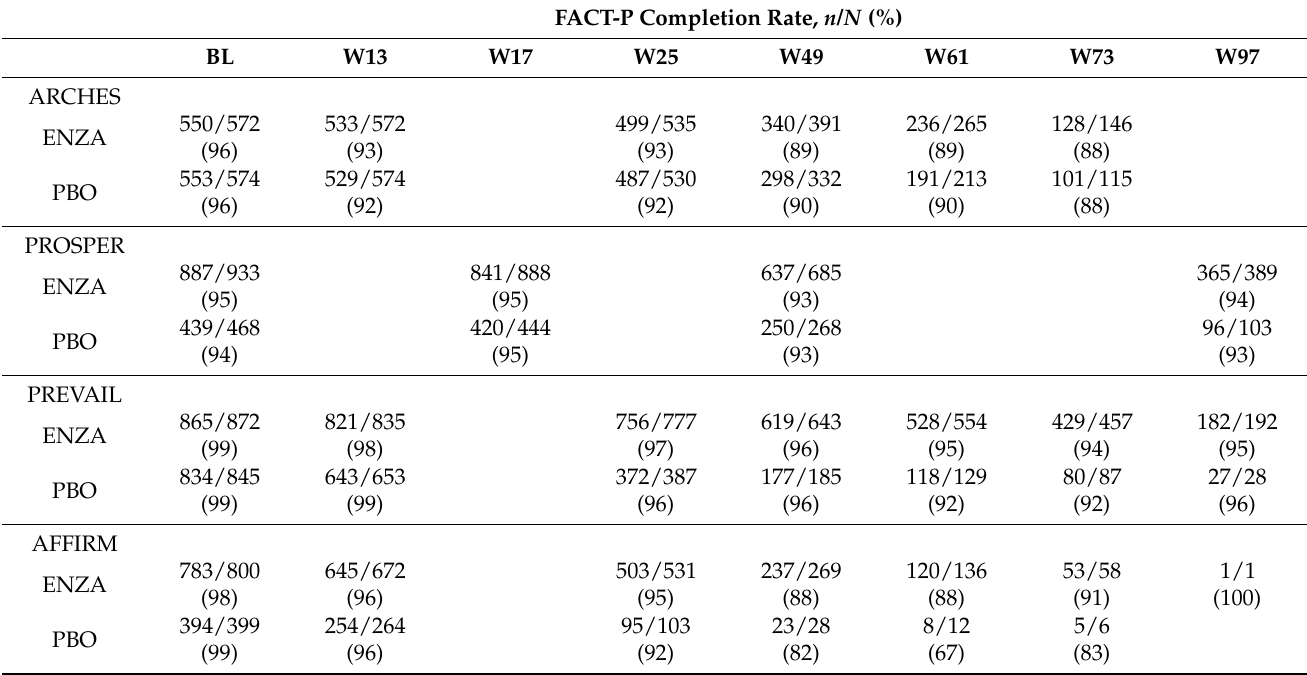
Table A2. Completion rates for FACT-P across studies.